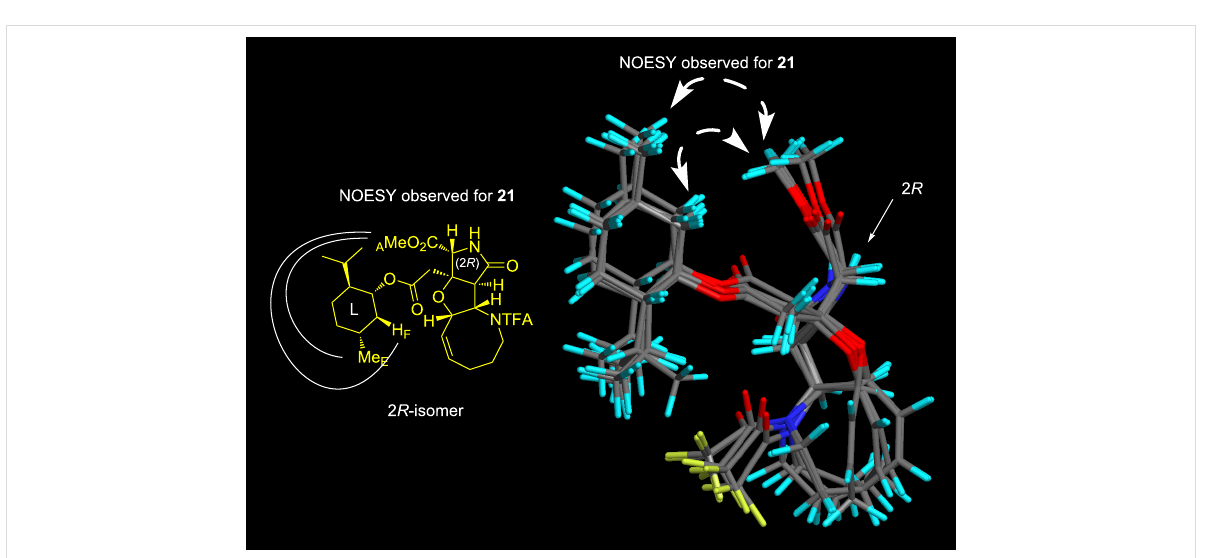
Figure 8: Superimposed structures of the top 5 stable conformers (76.8% total population) generated by CONFLEX (MMFF94S) for the (2 R )-isomer, which is consistent with the NOESY crosspeaks observed for 21 (400 MHz, CDCl 3 ). See Supporting Information File 5 for the stereo diagram.